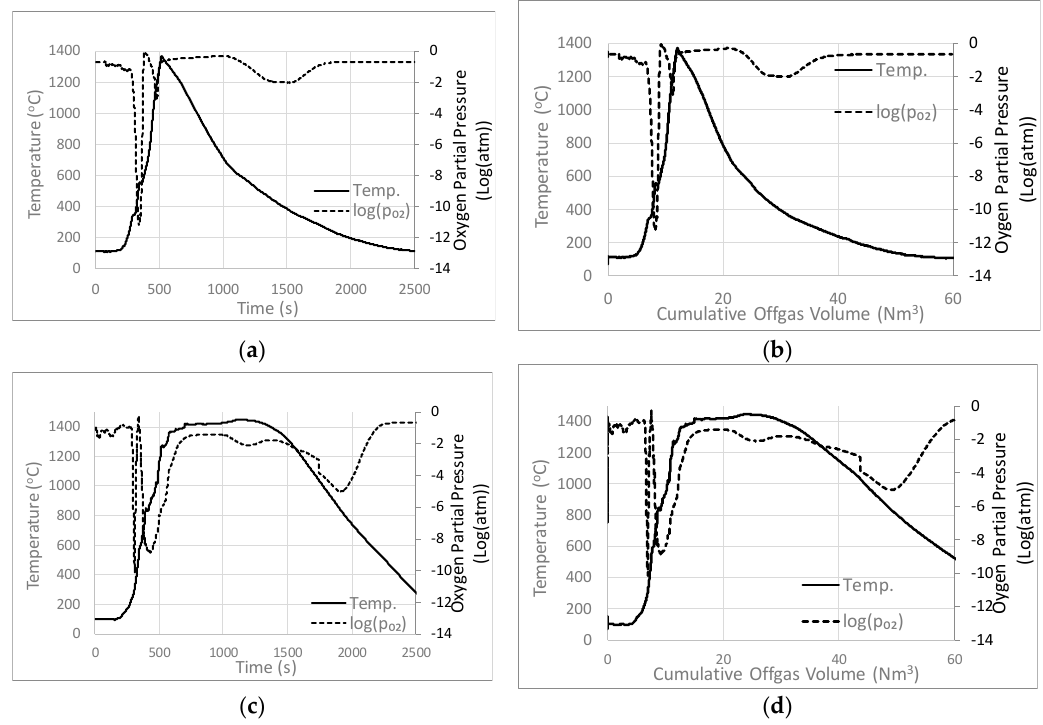
Figure 4. Temperature and p O2 profiles measured for ( a , b ) low coke (14.7 kPa draft pressure, 33 kg coke /t feed ) and ( c , d ) high coke (14.7 kPa draft pressure, 39 kg coke /t feed ) additions.